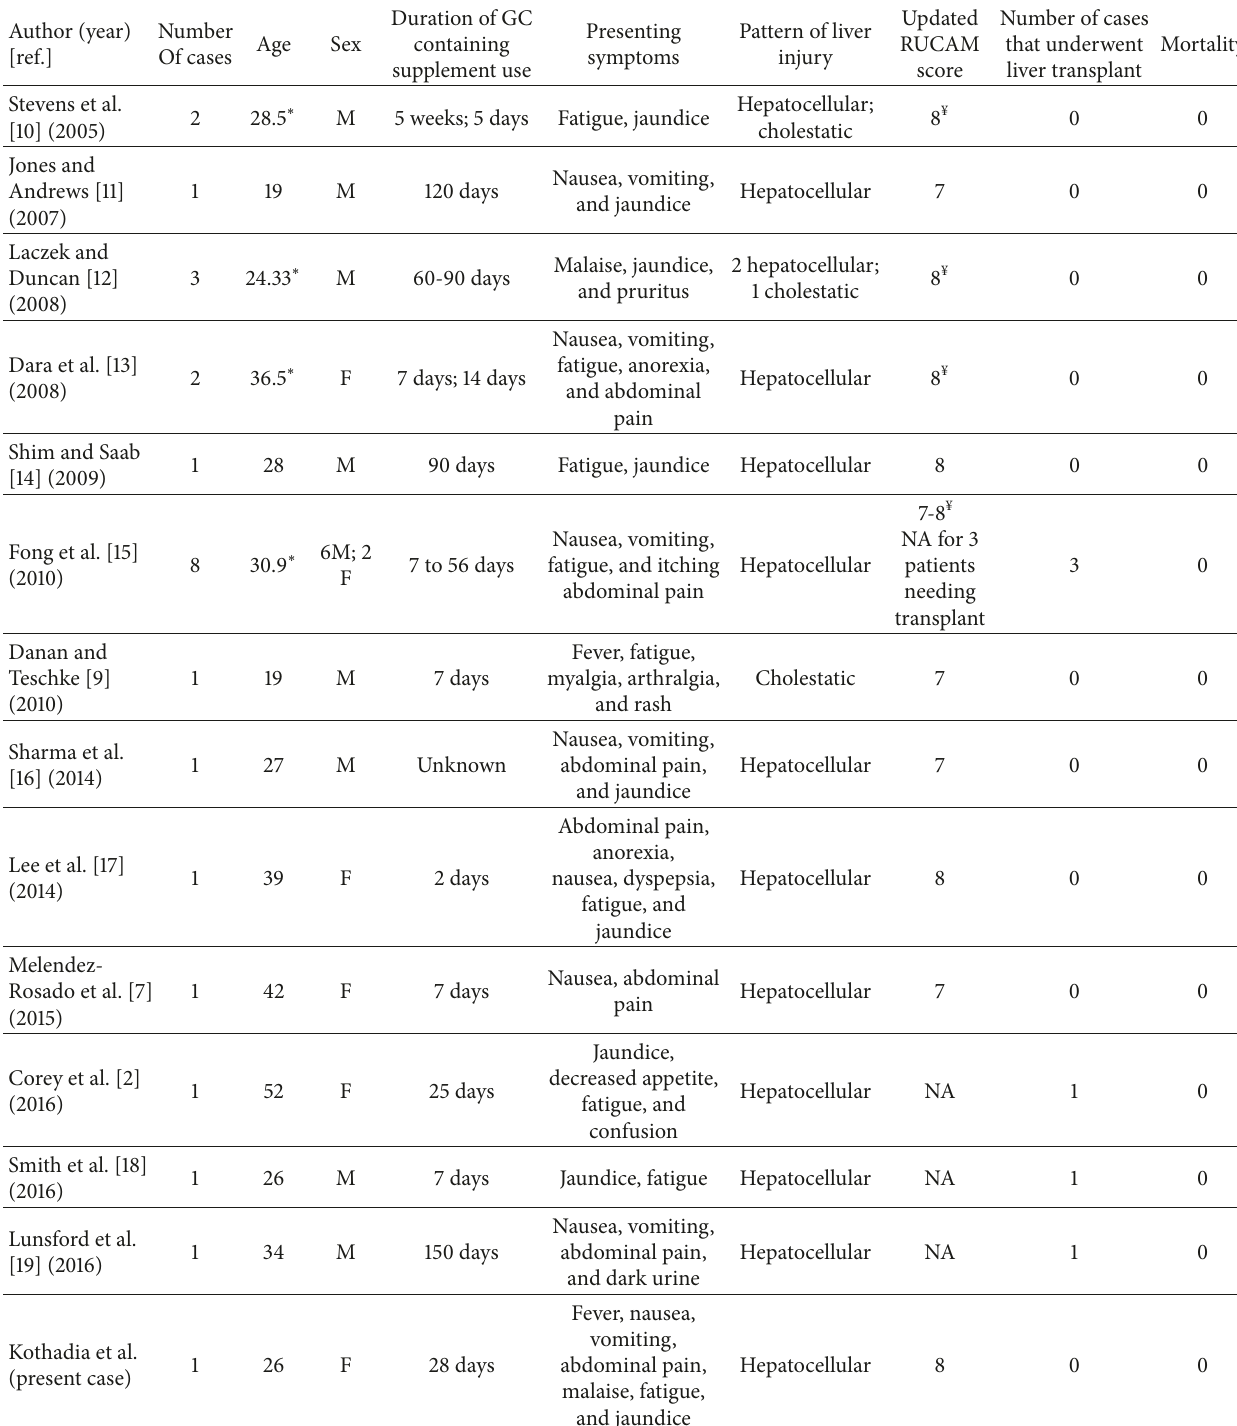
Table 1: Summary of patients with Garcinia cambogia related liver injury, characteristics, presentation, pattern of liver injury, and clinical